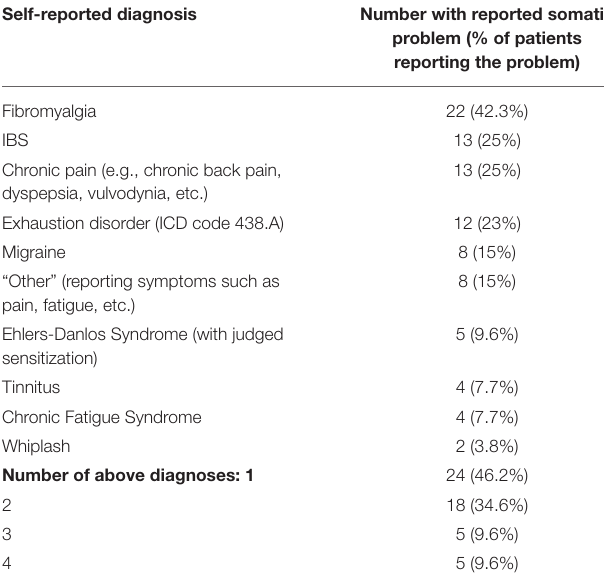
TABLE 3 | Self-reported somatic problems of patients.